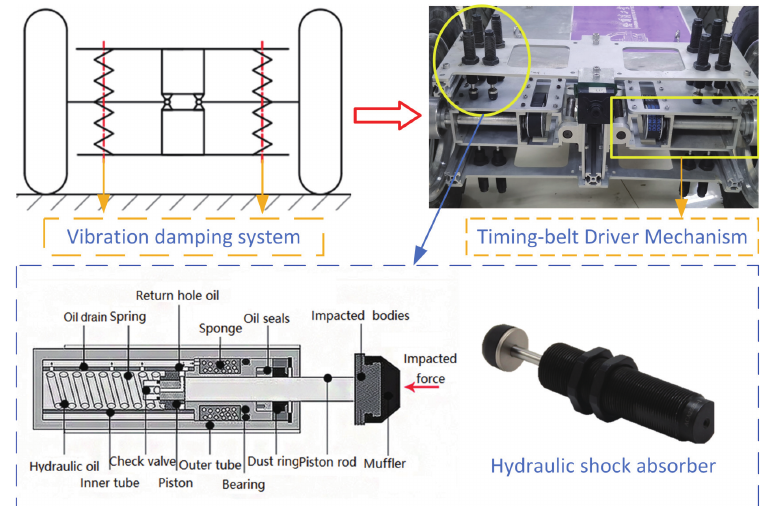
Figure 5. The vibration damping system and the shock absorber of the chassis. The control system frame diagram of the mobile robot is shown in Figure 6, the controller of the mobile robot uses the control board based on the ARM Cotex-M4 core and integrates the IMU module, and each timing-belt servo system has an independent driver. The controlling cycle of the mobile robot controller is 10 ms, and the trajectory of the mobile robot is estimated through the IMU and the angle encoder of the timing-belt servo system.